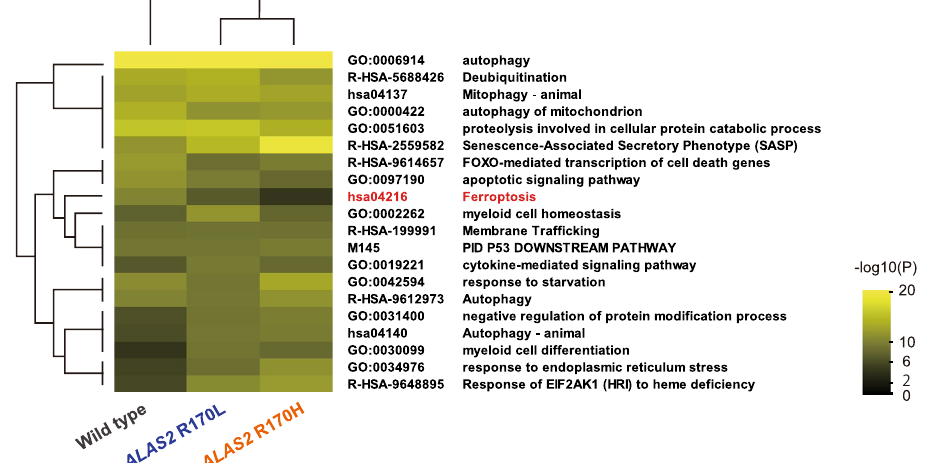
Figure 4. Genes associated with oxidative stress protection are differentially expressed during erythroid differentiation. Enrichment analysis of HUDEP-2 clones using Metascape 59 . After 6 day differentiation with SFC, 1265, 1750, and 1386 genes were upregulated (> 2-fold) for HUDEP WT , HUDEP R170L , and HUDEP R170H , respectively, compared with the undifferentiated HUDEP WT . These genes were analyzed, and enriched gene clusters were displayed as a heatmap that shows hypergeometric P -values of each annotated term. The heatmap is visualized using Java TreeView version 1.1.6r4 (jtreeview.sourceforge.net). EIF2AK1, eukaryotic translation initiation factor 2-alpha kinase 1; HRI, heme-regulated